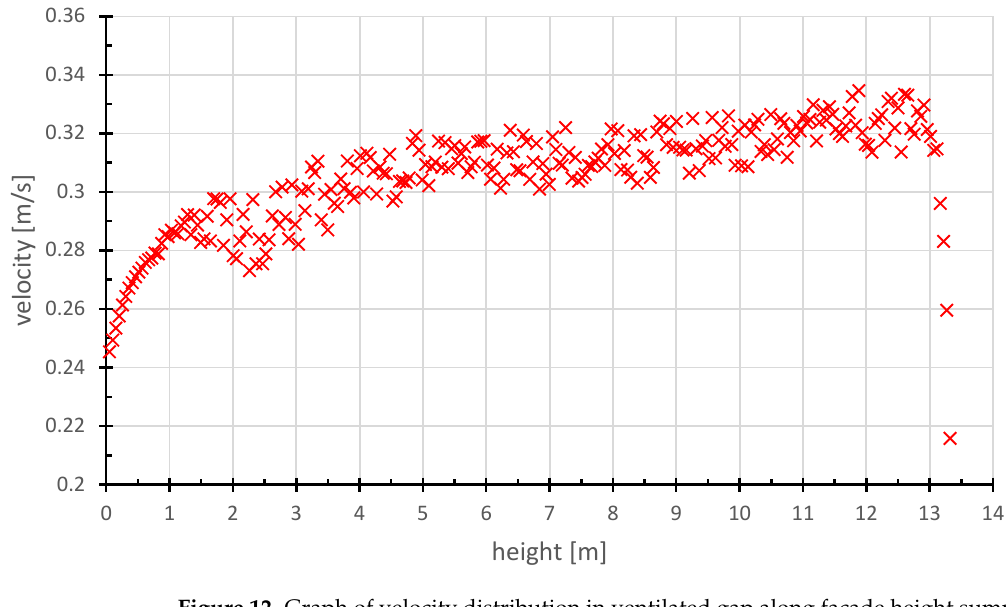
Figure 12. Graph of velocity distribution in ventilated gap along façade height summer extreme.